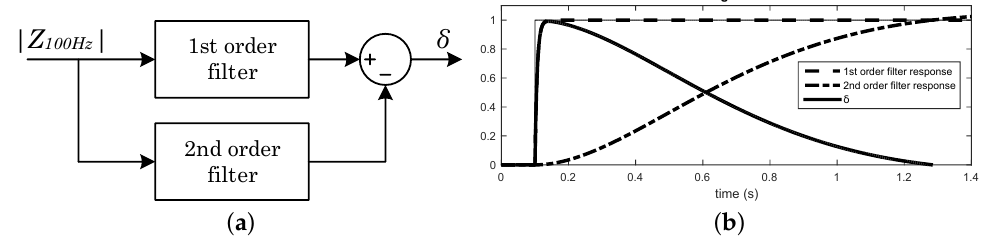
Figure 15. Trip generation method ( δ pulse). ( a ) Generation of the δ signal. ( b ) δ pulse